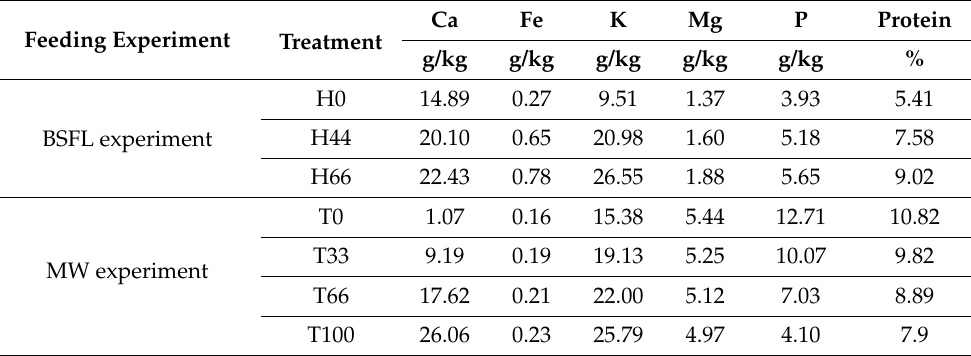
Table 3. The nutrient composition of the initial substrates used in both feeding experiments. Feeding